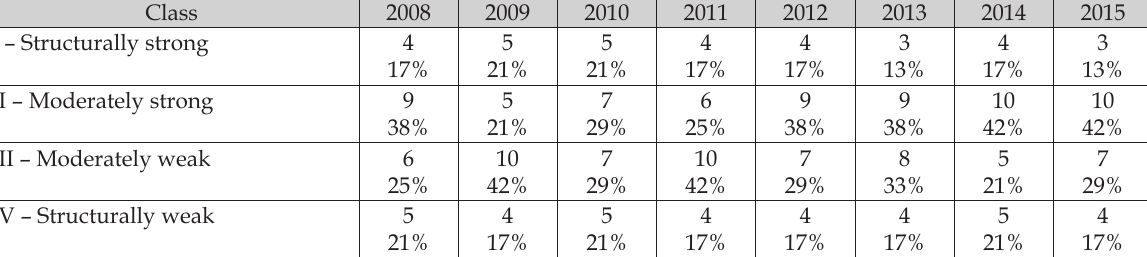
Table 4. Number and percentage of rural regions in each class for Austria,